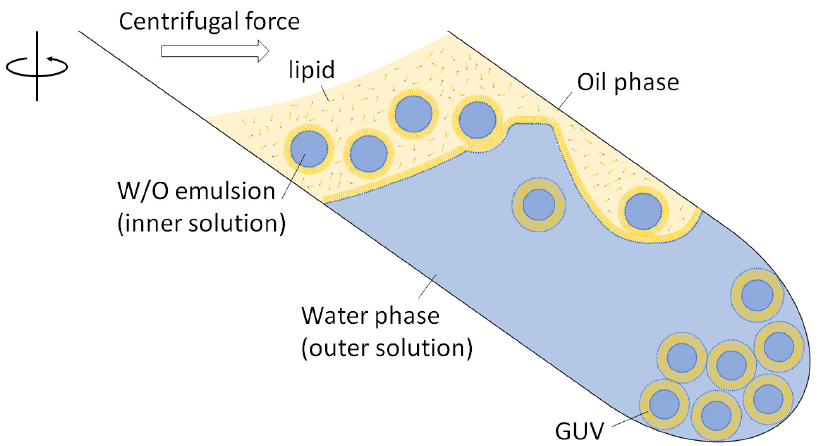
Figure 2. Schematic illustration of GUV preparation via the W/O emulsion template method using centrifugation.